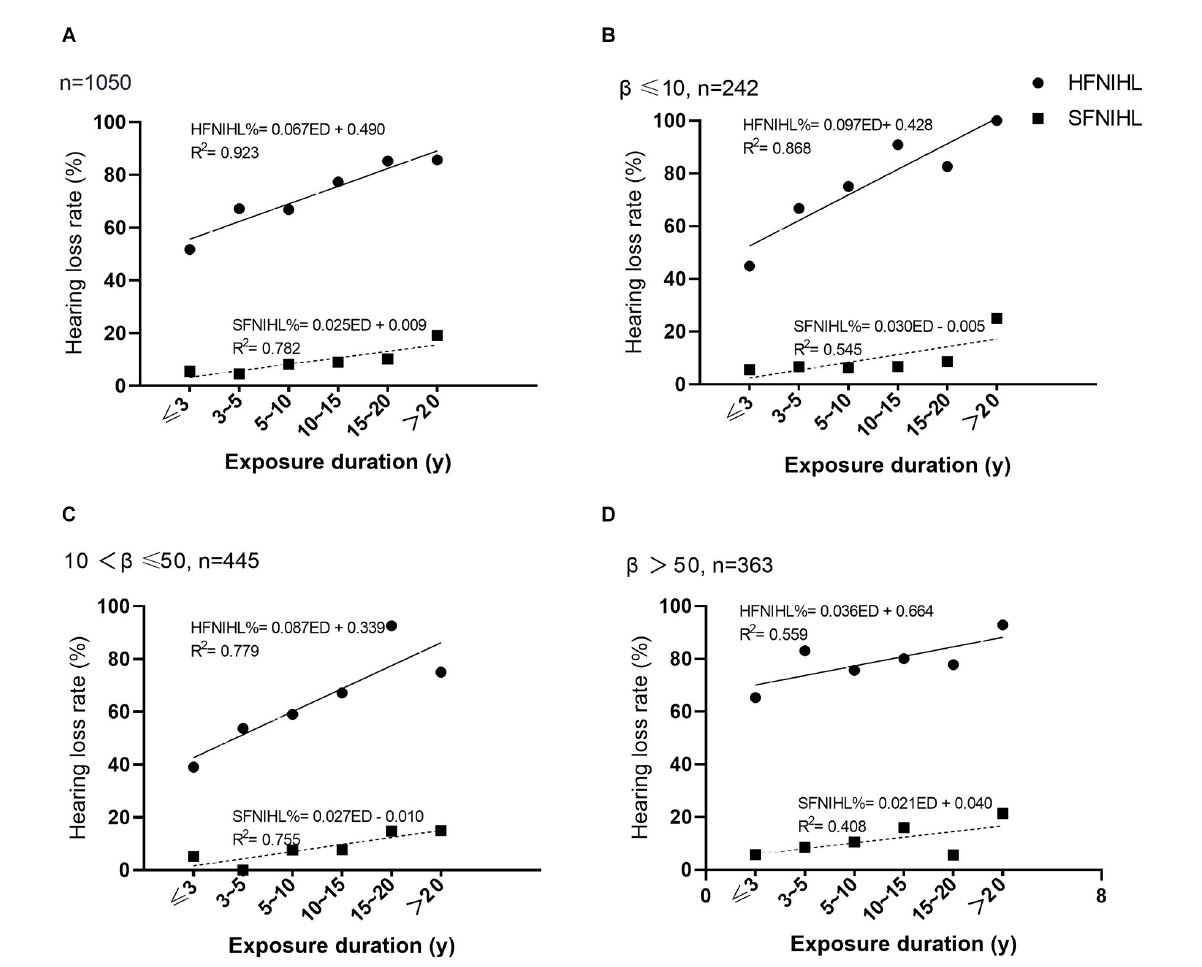
FIGURE1 The relationship between noise exposure duration and hearing loss at different kurtosis levels. (A) The HFNIHL% and SFNIHL% of different noise exposure duration groups. (B) The HFNIHL% and SFNIHL% of different noise exposure duration groups when β ≤ 10. (C) The HFNIHL% and SFNIHL% of different noise exposure duration groups when β was between 10 and 50. (D) The HFNIHL% and SFNIHL% of different noise exposure duration groups when β >